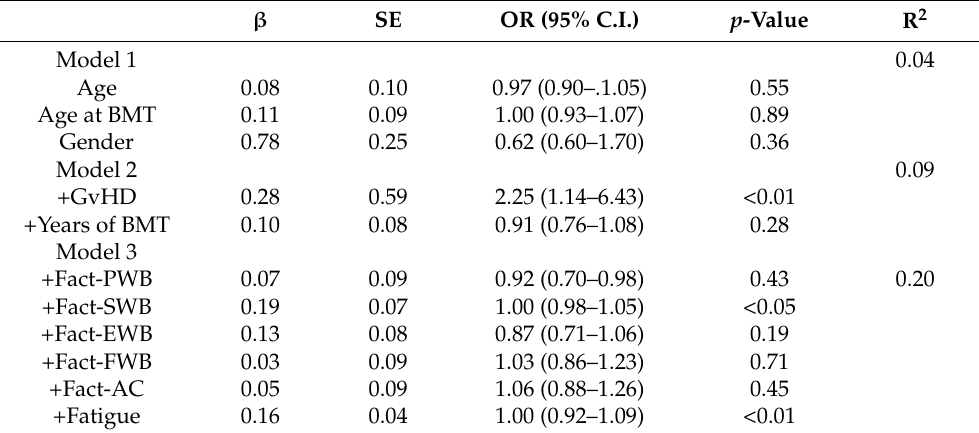
Table 2. Variables significantly predicting severity of PTSD symptoms: results from binary logistic regression